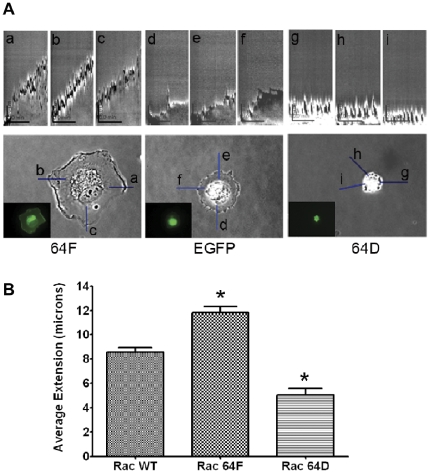
Expression of Rac1-Y64F or Rac1-Y64D altered lamellipodial dynamics.HUVEC cells were transfected with EGFP, or EGFP-tagged Rac1-Y64D, or Rac1-Y64F. Cells were plated onto fibronectin-coated coverslips two days after transfection, and were observed under phase contrast microscopy until initial attachment was achieved (typically 10 minutes). Images were taken every 20 seconds for 20 minutes. Kymograph analysis of cell spreading efficiency was performed using these serial images. (A) Three sets of kymographs are shown from each transfected cell: a–c for EGFP-Rac1-Y64F; d-f for EGFP and g-i for EGFP-Rac1-Y64D. The lower panel shows the transfected cells that were studied with the line scan used for kymograph. The inset shows the GFP signal of the transfected cells. (B) Kymography from three to six transfected cells were analyzed to study the differences in their spreading. Significant differences in lamellipodial extension were noted in both cells expressing Rac1-Y64F and Rac1-Y64D when compared with HUVEC expressing Rac1-WT (p values  =  0.0377 and 0.0005 respectively).